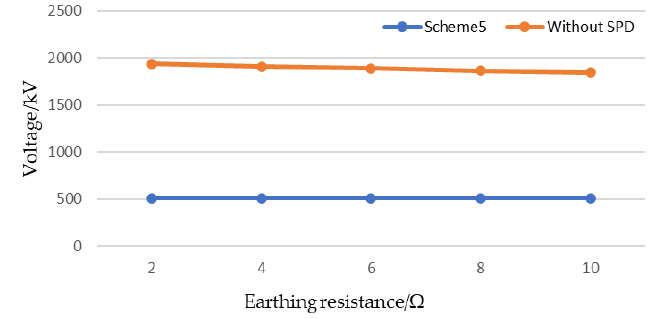
Figure 11. Effect of earthing resistance on difference of overvoltage between the down-conductor and CFN.